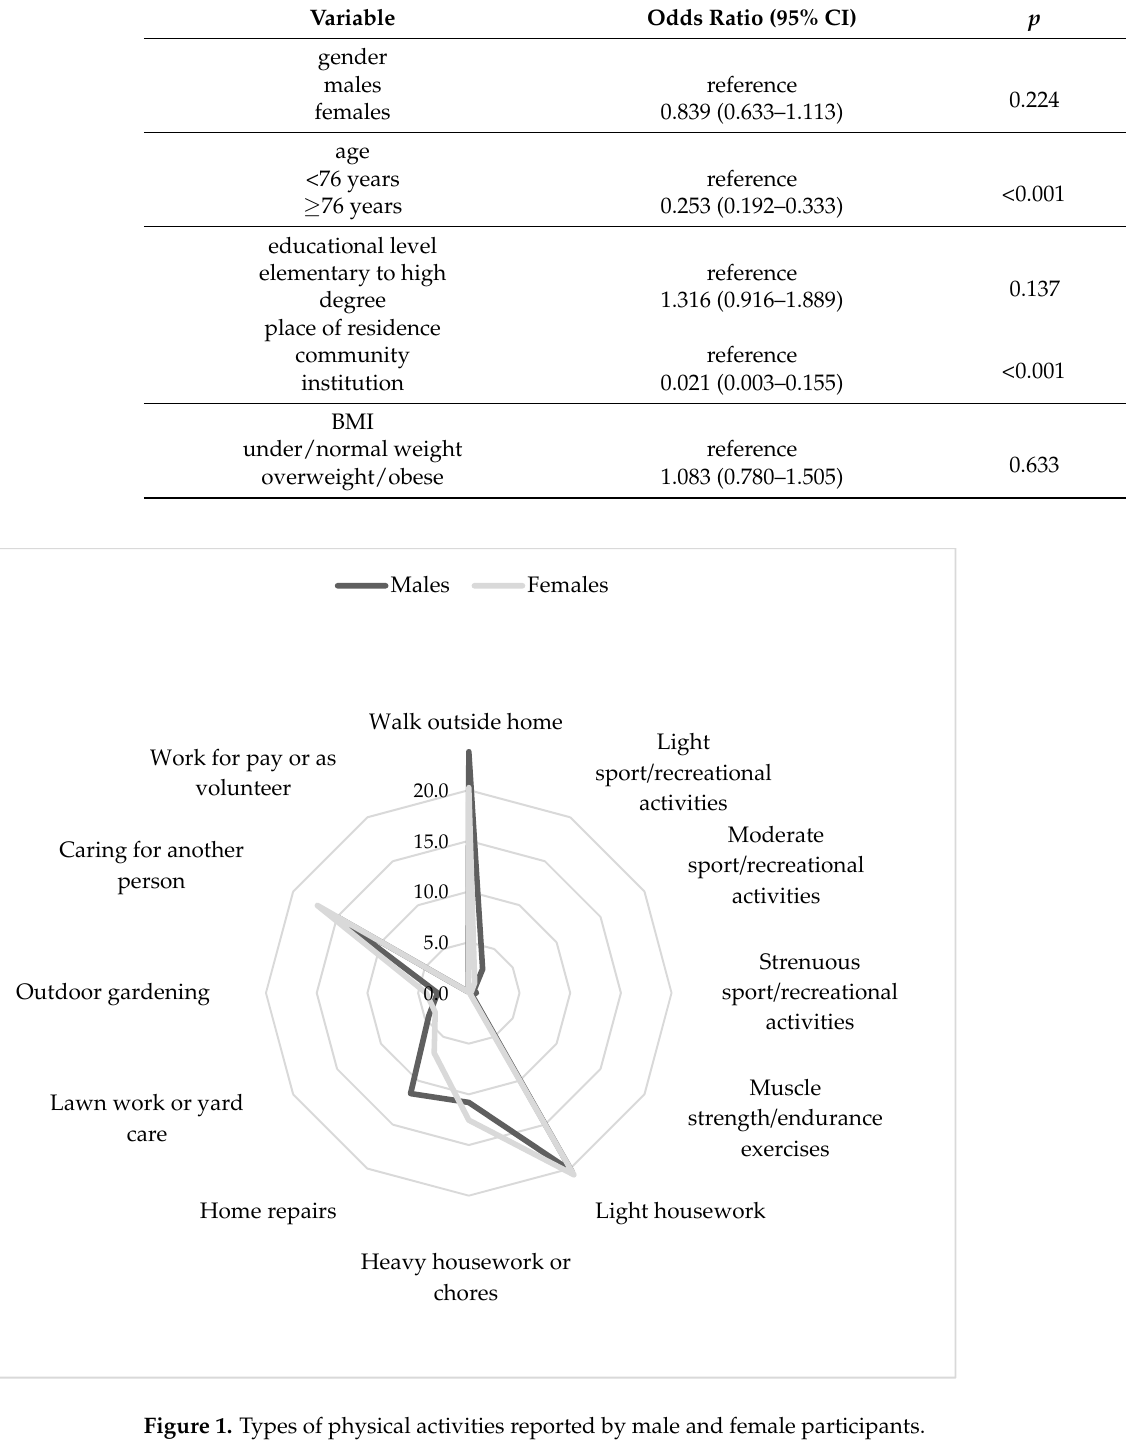
Figure 2. Total PASE scores by age group in male and female participants ( p < 0.001). In the correlation analyses, only age (Spearman’s Rho − 0.447, p < 0.001) and place of residence (Tau-b − 0.314, p = 0.000) were found to be related to PASE scores among the